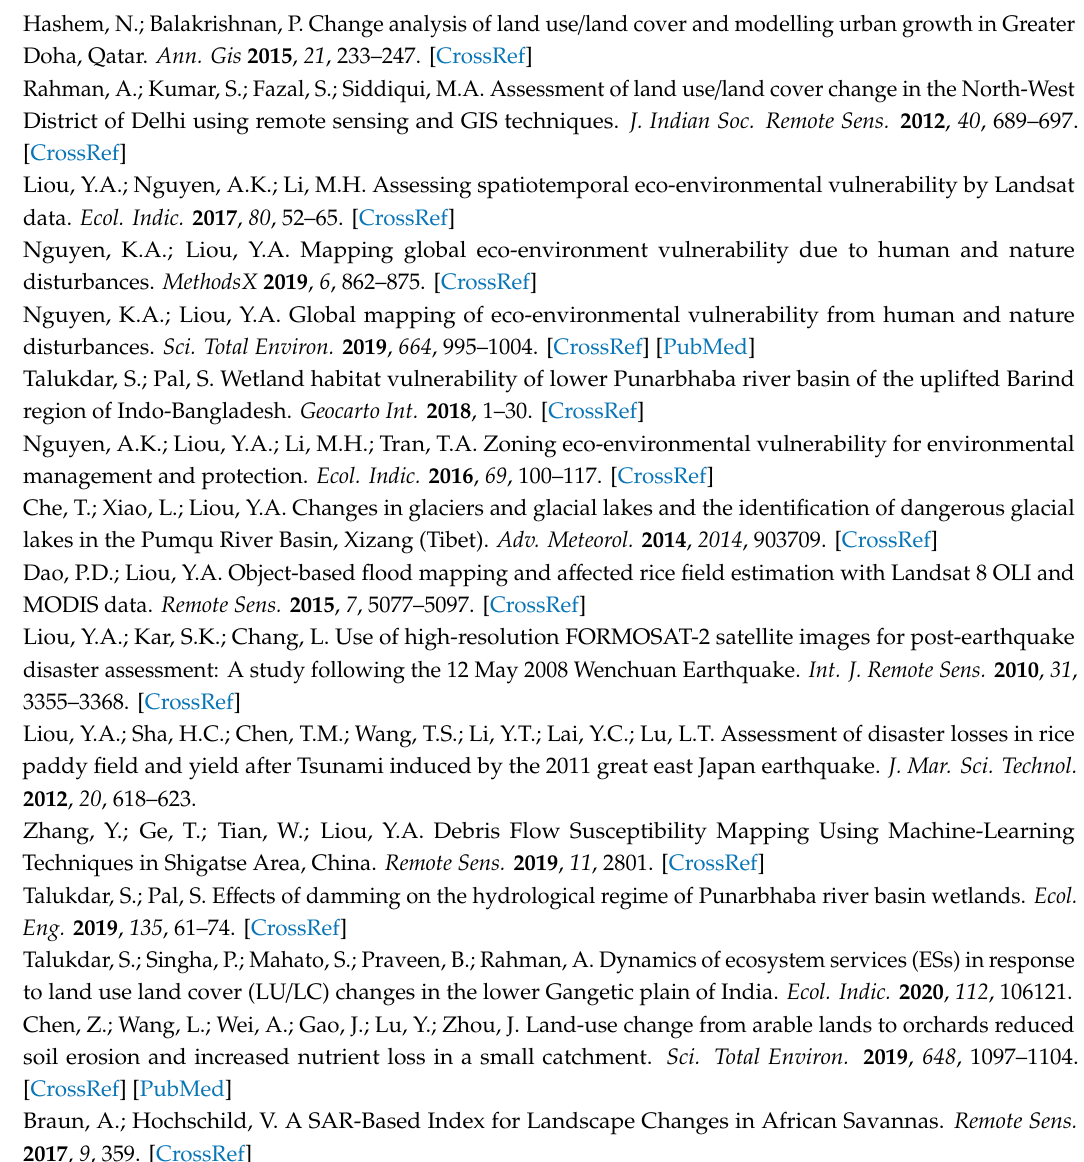
Table S1: The accuracy assessment of LULC mapping of six classifiers using Kappa coe ffi